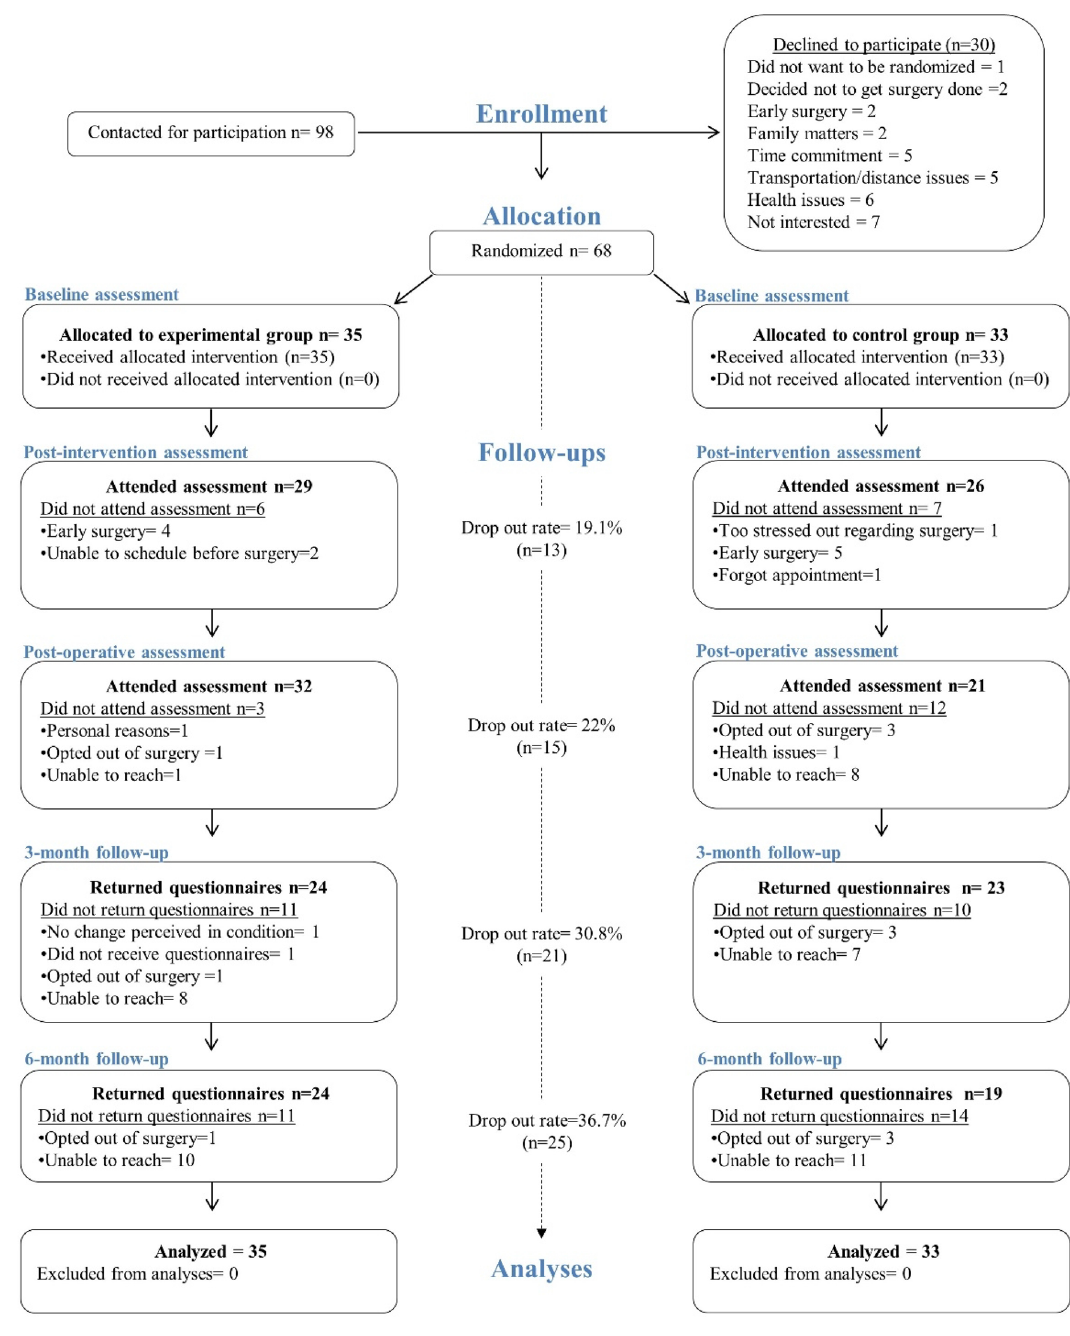
Figure 1. CONSORT flowchart of the randomized controlled